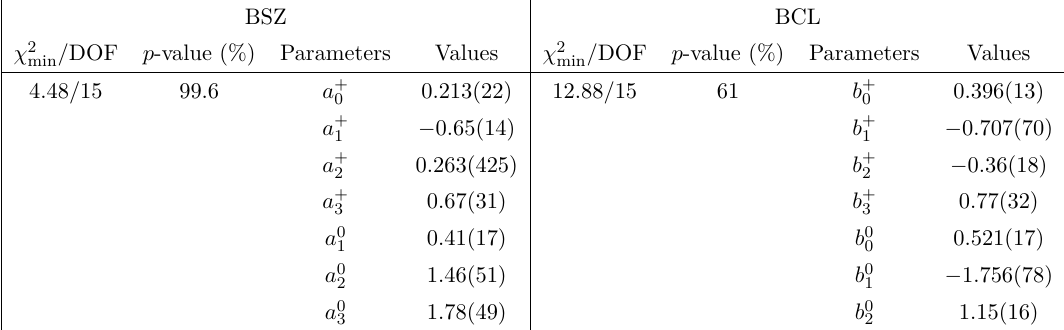
Table 7 . Fit results of form factor parameters with only LCSR and lattice input. Used to create the plots in figure